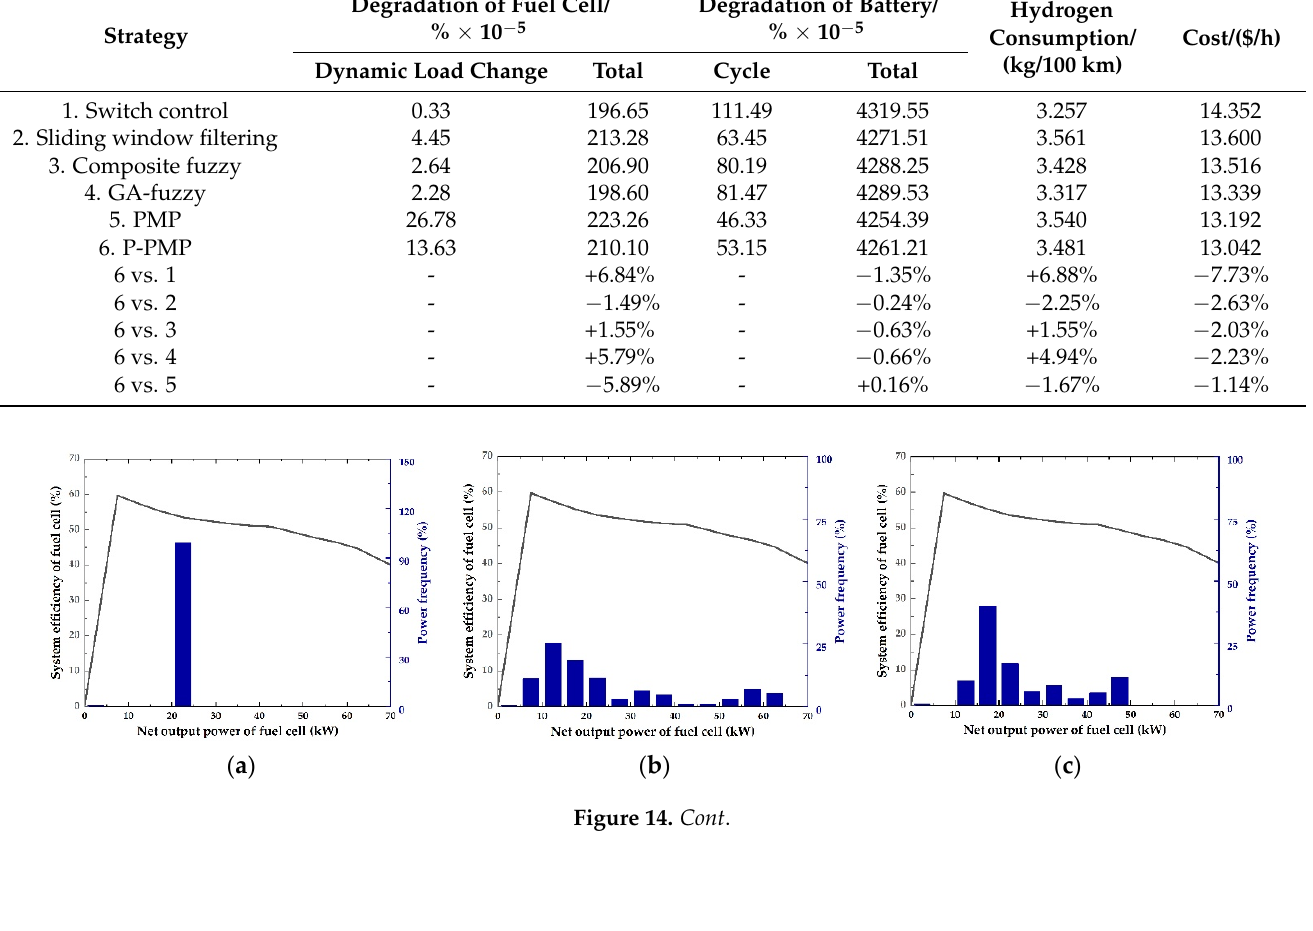
Table 6. Comparison of fuel economy and power system durability under different strategies. Strategy